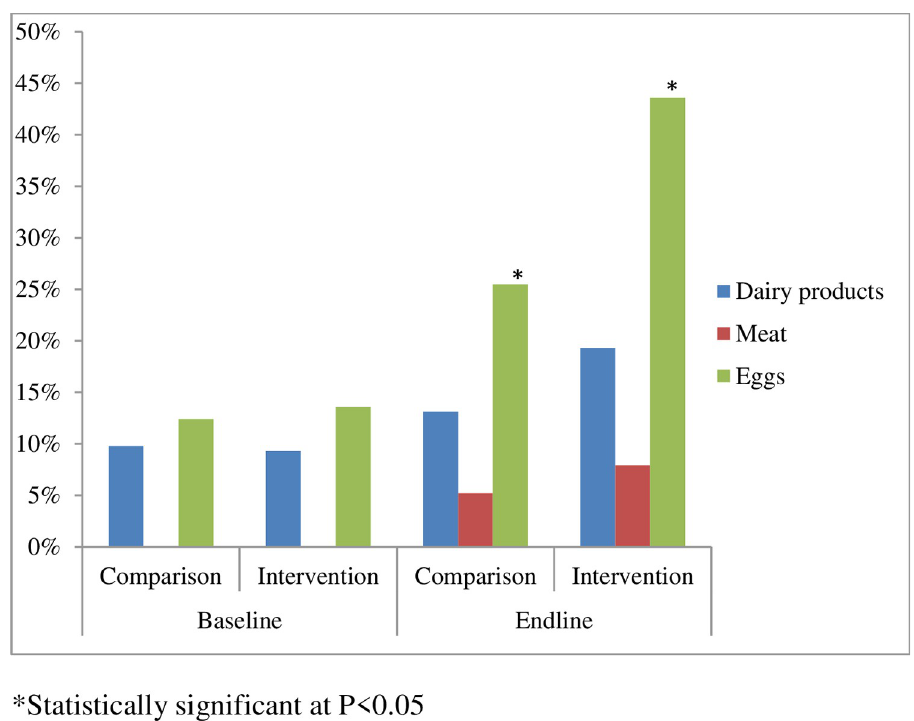
Fig 3. Percentage of overall study children who consumed ASFs in the intervention group compared to the comparison group over the fellow up period.